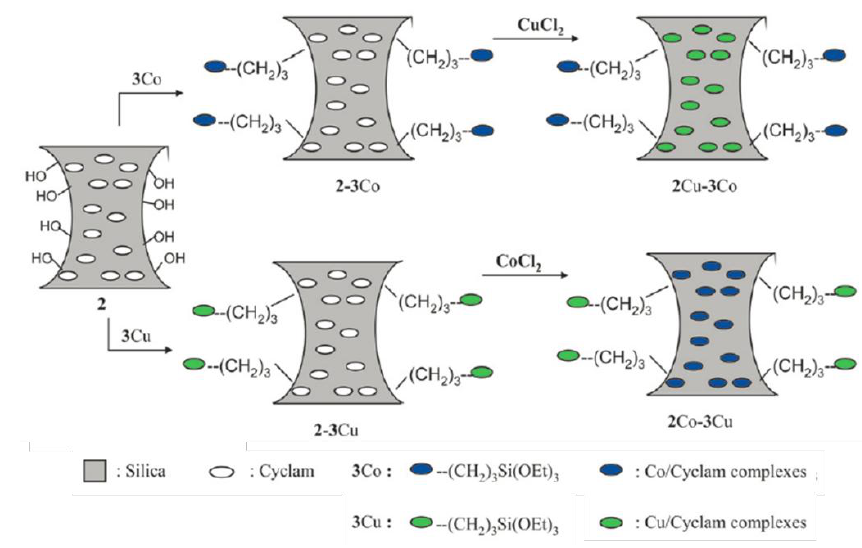
Figure 8. The schematic illustration of the grafting and incorporation process of Cu/Co in the PMOs. Reproduced from Ref. [90], Copyright 2010, with permission of The Royal Society of Chemistry.